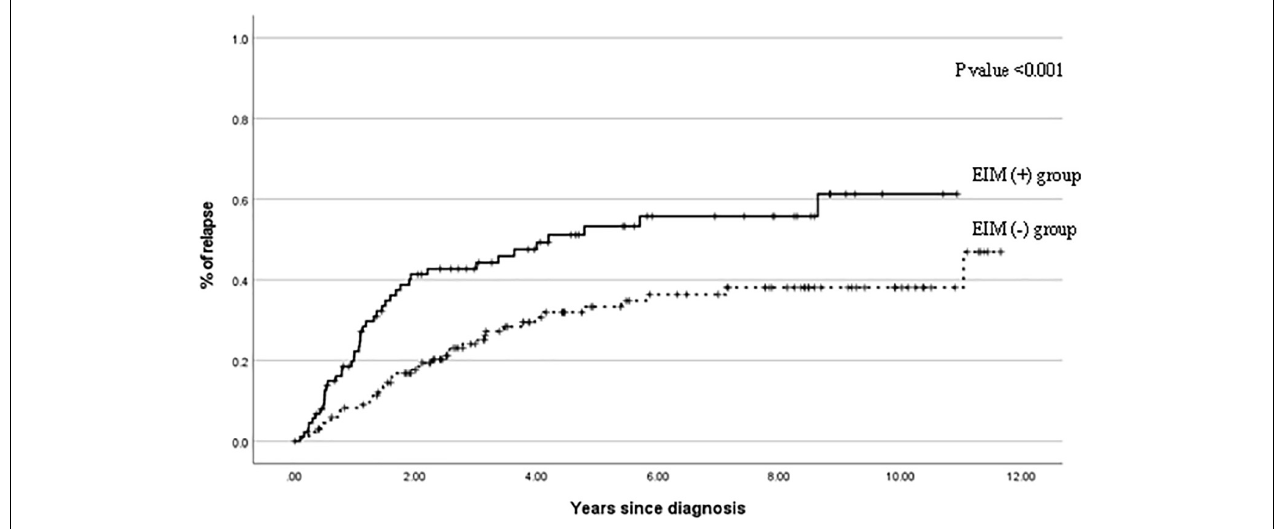
FIGURE 5 | Cumulative probability of relapse events in patients with EIM (+) and patients with EIM ( − ) over 10 years after the diagnosis. EIM, extraintestinal manifestation.